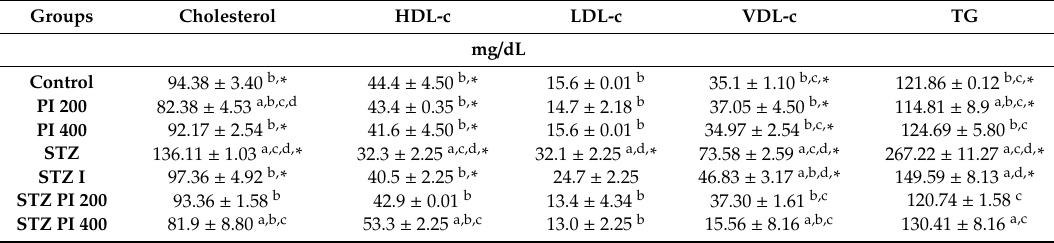
Data in the table above represents mean ± standard deviation, n = 10. a —compared with control, b —compared with STZ only, c —compared with STZ I, d —compared with STZ PI 200, * —compared with STZ PI 400. Values are statistically significant at p < 0.05.